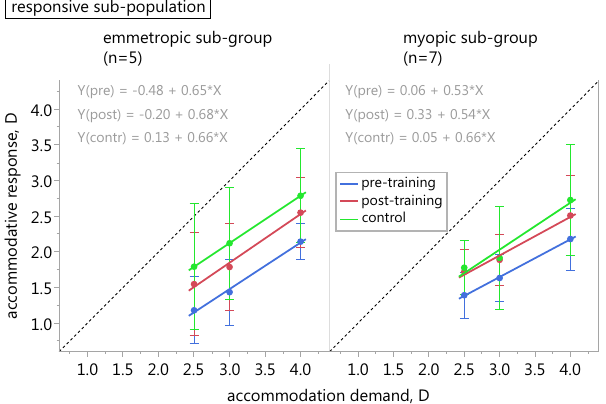
Figure 4. Accommodation in responsive subjects with control measurement. Stimulus-response functions of responsive emmetropic (n = 5, left) and myopic subjects (n = 7, right) at baseline (blue), after the biofeedback training (red), and in the control measurement one week later (green) in multifocal contact lens wear, respectively. The dashed line has a slope of 1; error bars are SD of the